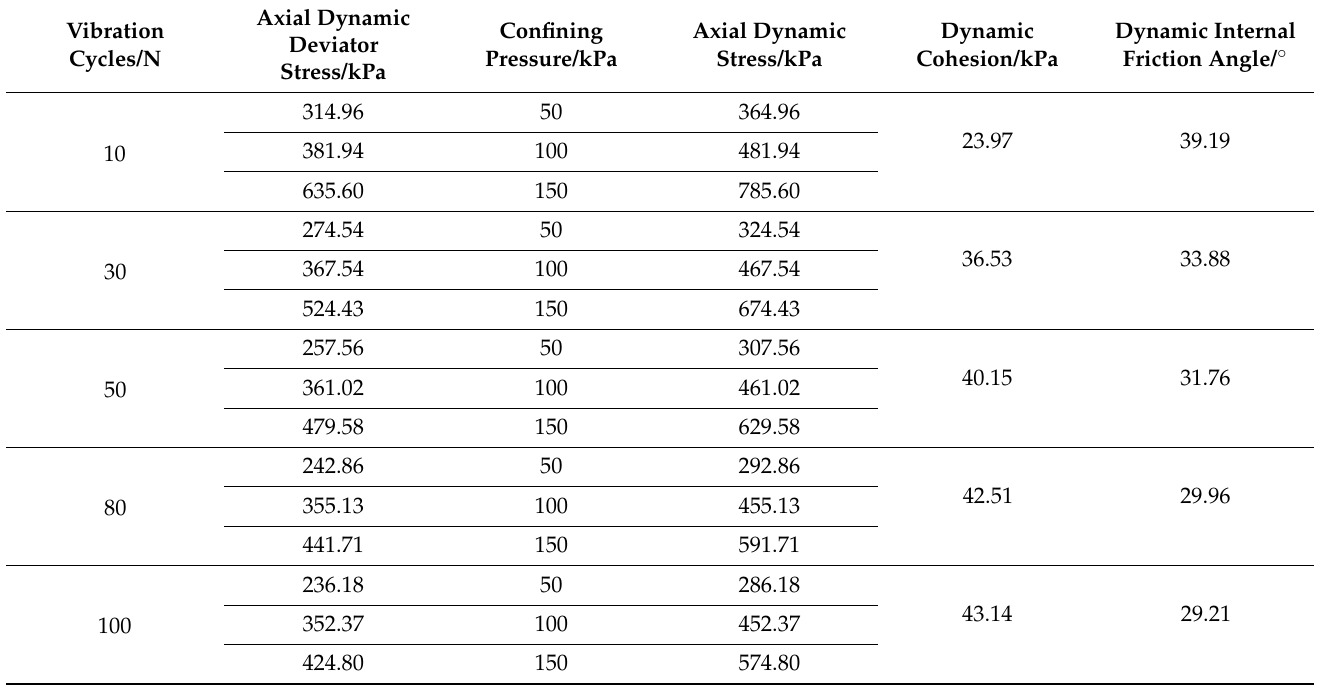
Table 2. Dynamic mechanical parameters of soil